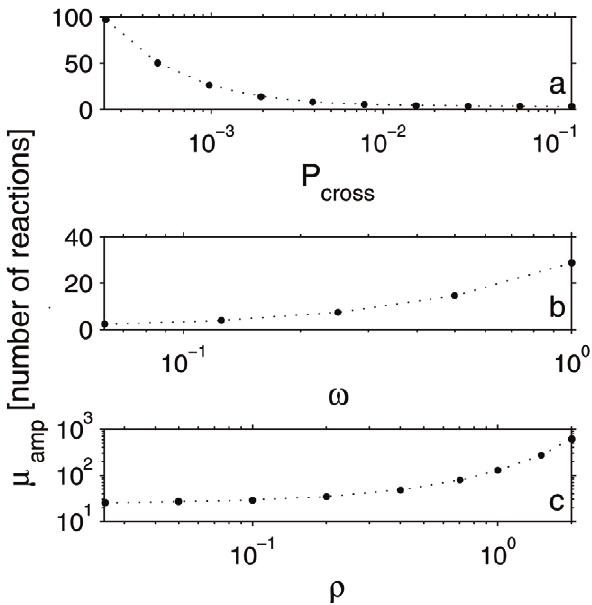
Figure 5. The mean burst amplitude versus model parameters, obtained by Monte Carlo simulations. a. the effect of confinement strength on m amp . P cross varies between 2 { 12 and 2 { 3 . Other parameter values are: v ~ 1 , N ~ 200 , L ~ 20 a , t dim ~ 1 , r ~ 0 : 1 . In order to identify bursts, we considered t ~ 1 : 282 | 10 4 ,6 : 950 | 10 3 ,3 : 461 | 10 3 ,1 : 832 | 10 3 ,1 : 022 | 10 3 ,5 : 964 | 10 2 ,3 : 873 | 10 2 ,2 : 789 | 10 2 ,2 : 323 | 10 2 ,2 : 096 | 10 2 , for P cross ~ 2 { 12 ,2 { 11 , ::: ,2 { 3 , respectively. b. m amp as a function of v , with other parameters fixed at: P cross ~ 9 | 10 { 4 , N ~ 200 , L ~ 20 a , t dim ~ 1 , r ~ 0 : 1 . c. m amp as a function of density. Parameters were fixed at: v ~ 1 , N ~ 400 , L ~ 20 a , t dim ~ 1 , and r varies between 0.05 and 2 molecules per compartment. Error bars in all plots are smaller than the data points. In b and c , t ~ 3 : 912 | 10 3 simulation steps.